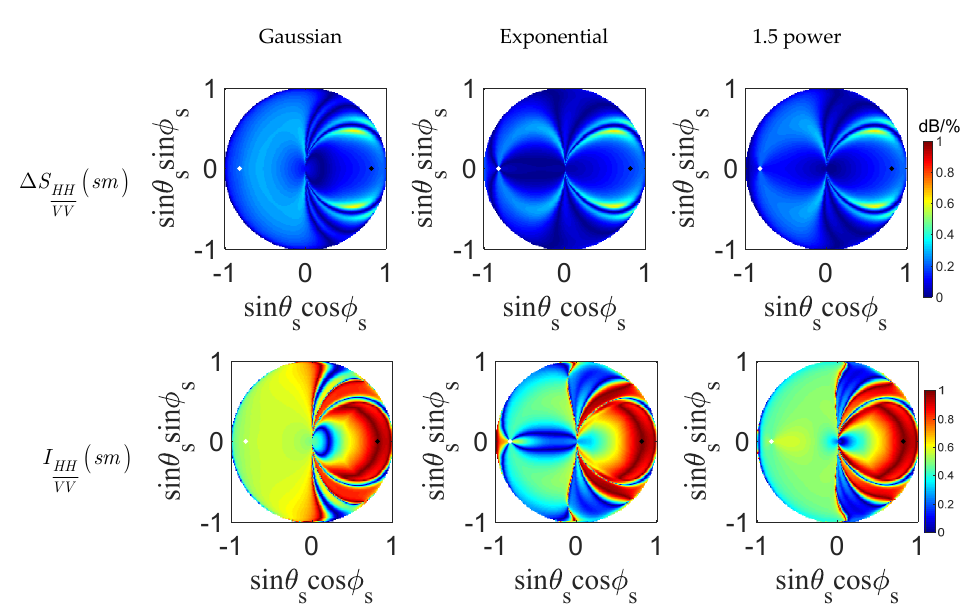
Figure 8. Patterns of dual-polarized sensitivity to soil moisture between 40% and 10% (first line), and the quality index I (second line).